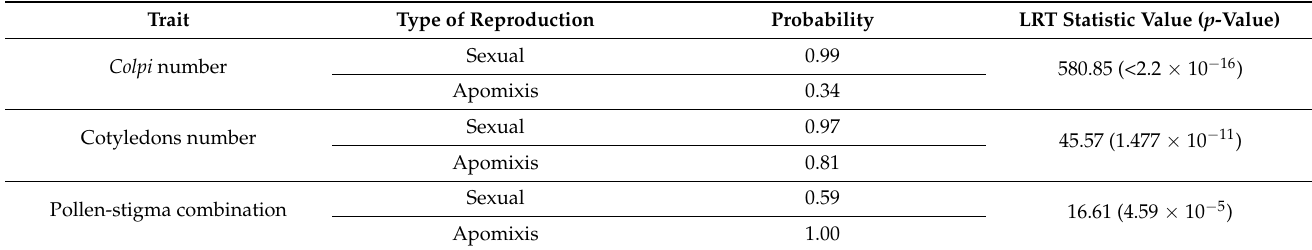
Table 2. The probability and the likelihood ratio test (LRT) and respective p -value for the traits studied.